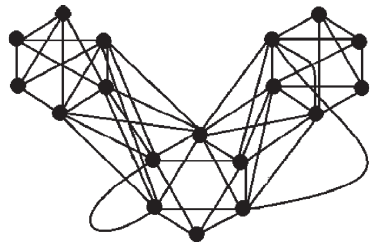
Figure 3: Graph of L ( CS ( 3 ))